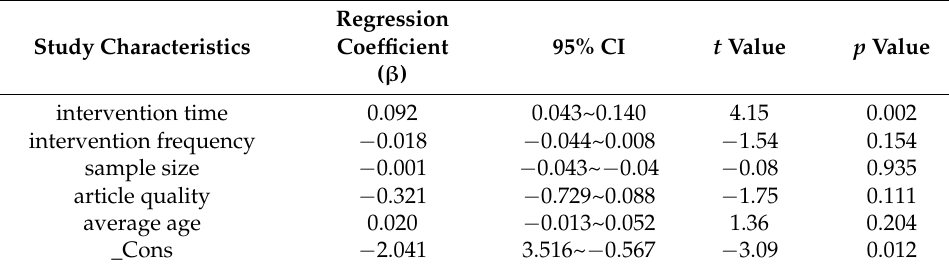
Table 2. Meta-regression analysis of heterogeneity factors affecting PSQI index effect